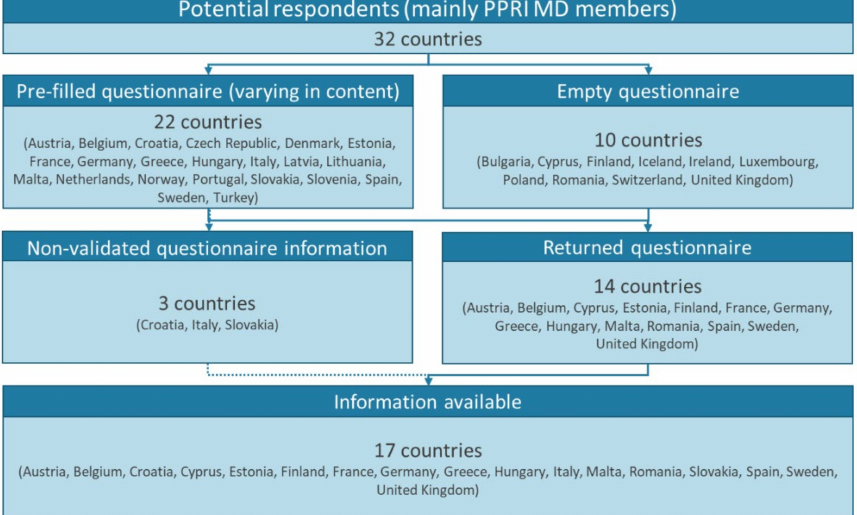
Figure 2. Study countries. MD: medical device(s); PPRI MD: Pharmaceutical Pricing and Reimburse- ment Information Subgroup on Medical Devices.